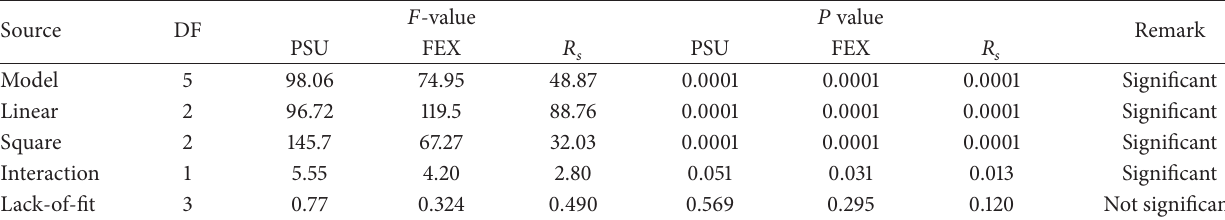
Table 4: ANOVA for 2 3 full factorial design: responses are retention times of the drugs (PSU and FEX) and resolution ( 𝑅 𝑠 ).